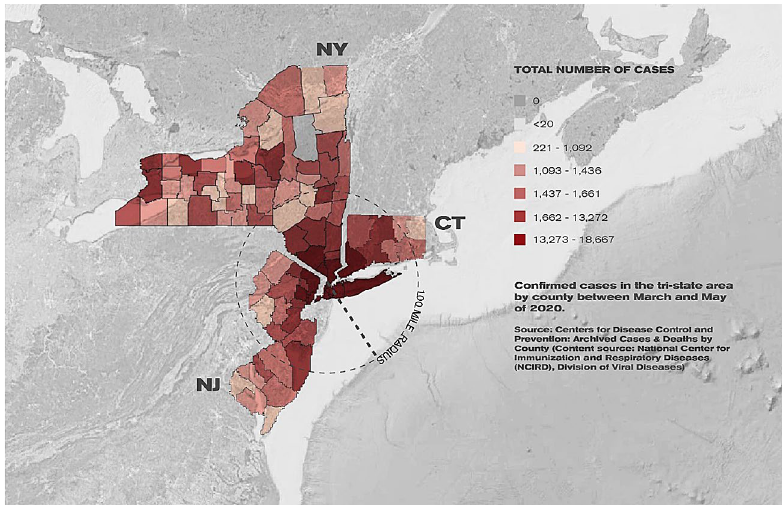
Figure 1. Confirmed cases in the tri-state area by county between March and May 2020. The color-coded map showing the total number of COVID-19 confirmed cases were obtained from the Centers for Disease Control and Prevention Covid Data Tracker site, in the Archived Cases & Deaths by County section. The background base map was downloaded from Google Earth Pro and modified in Adobe Photoshop to make gray color tone. Google Earth map and color-coded data map were put together in Adobe Illustrator.